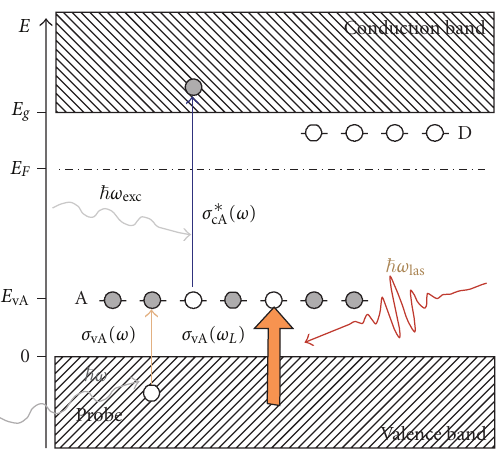
Figure 7: Scheme of optical transitions for the explanation of excitation (stimulation) spectroscopy of σ -DLSS. Acceptors ( A ) are compensated by shallow donors ( D ). Fat arrows, transitions of laser photoionization σ vA ( ω L ). Thin arrows, absorption of the probe and excitation